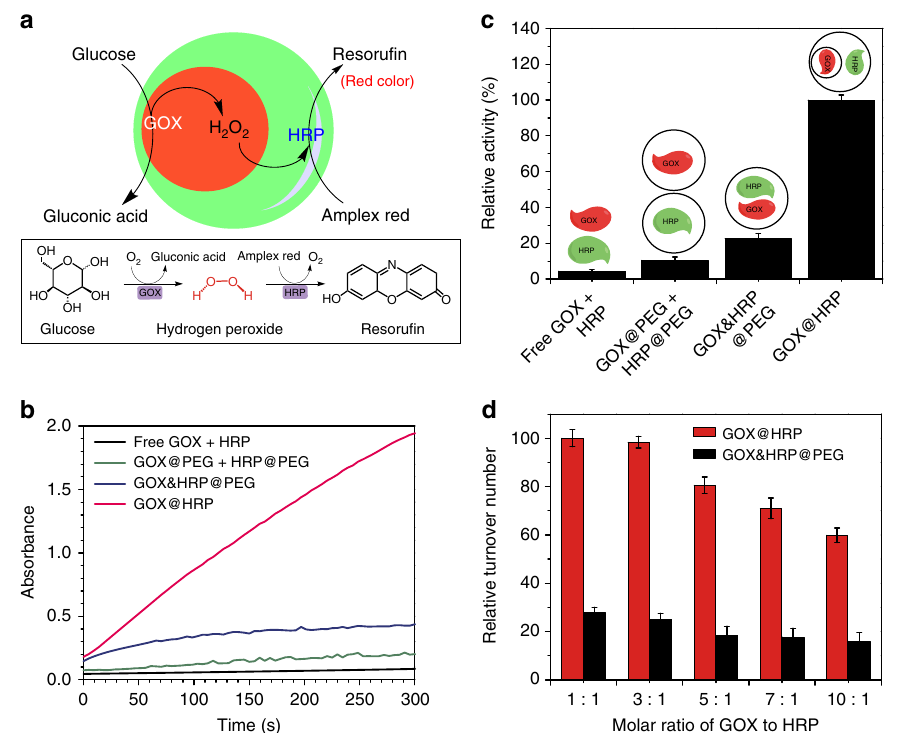
Fig. 3 Activity characterization of GOX@HRP. a Schematic illustration and reaction equations of GOX@HRP-catalyzed Amplex Red oxidation for the production of resoru fi n after initiation by glucose. b Time-dependent absorbance changes caused by the oxidation product of Amplex Red catalyzed by different tandem catalytic systems: a free GOX/HRP system, a GOX@PEG/HRP@PEG system, GOX&HRP@PEG, and GOX@HRP. c Relative activities of tandem catalytic systems based on a free GOX/HRP system, a GOX@PEG/HRP@PEG system, GOX&HRP@PEG, and GOX@HRP. d Relative turnover numbers of GOX@HRP and GOX&HRP@PEG system with molar ratios of GOX to HRP from 1:1 to 10:1